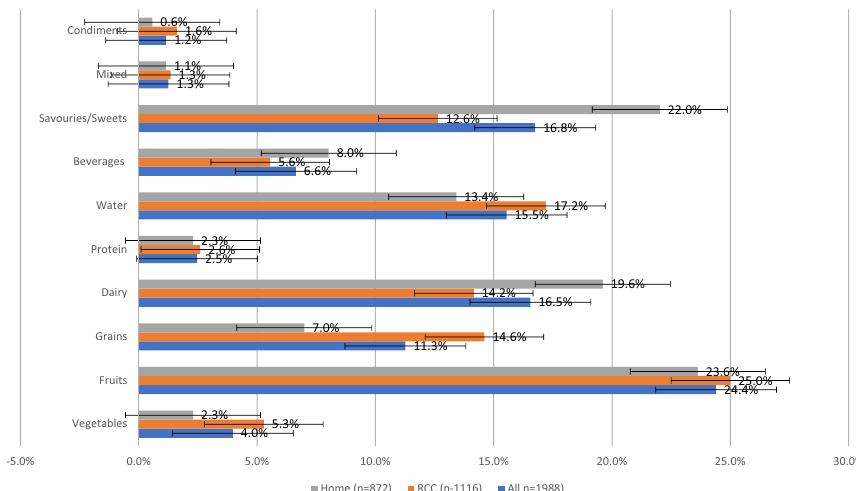
Fig. 2 Food category frequencies for all, regulated child care and home snacks. Snacks referred to the foods and dinks consumed outside of main